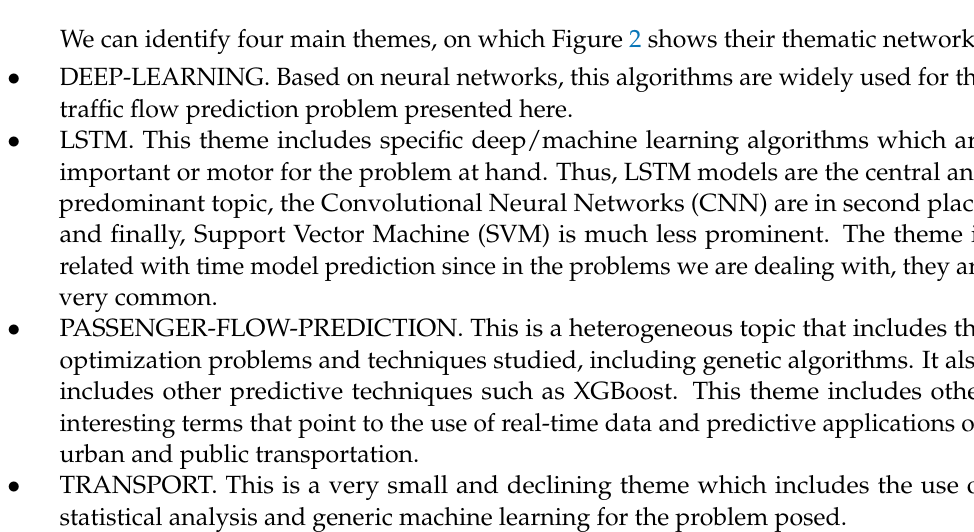
Figure 1. Strategic map of prediction of passegers using machine/deep learning in the literature.